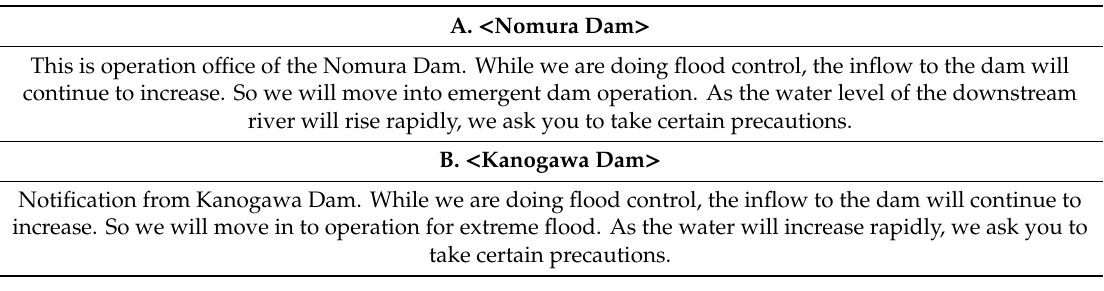
Table 2. Warning messages from dam operators (MLIT b [27]).